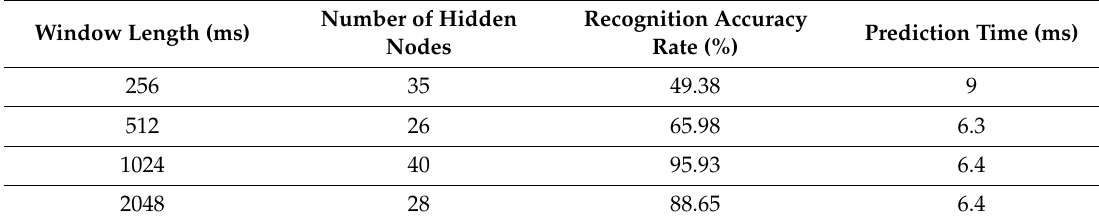
Table 3. Recognition accuracy using di ff erent sliding window